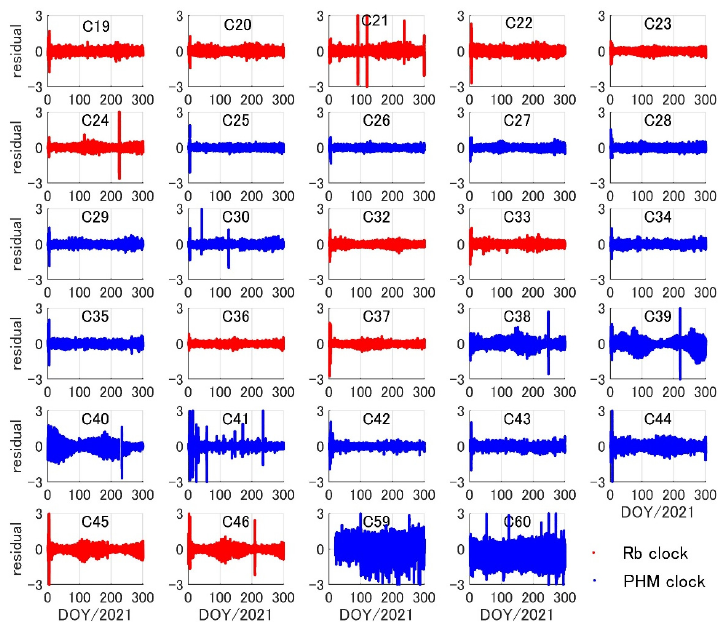
Figure 8. Fitting residual series of the BDS-3 onboard clocks from DOY 1 to 300, 2021 (units: ns).